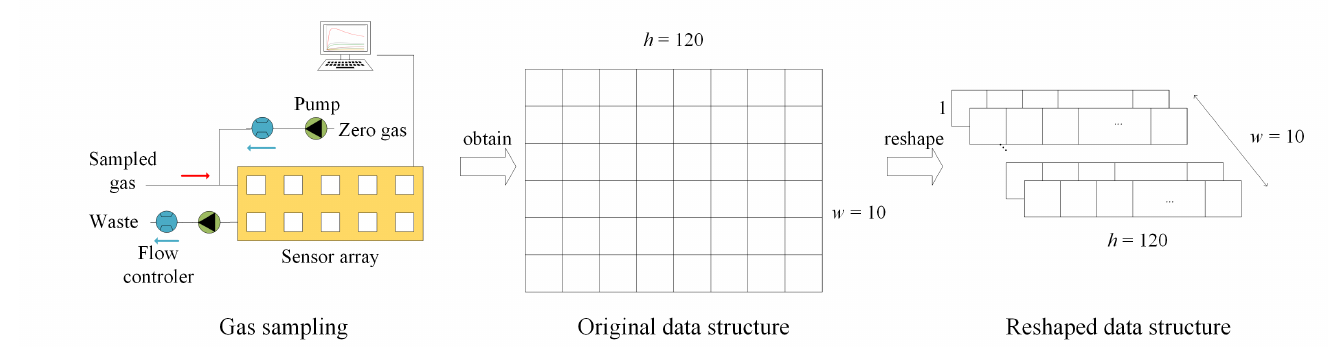
Figure 2. Input data from PEN3 e-nose.